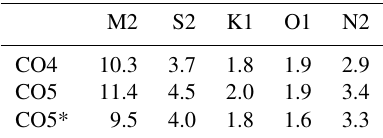
Table 4. Elevation RMSE of amplitude in centimetres as compared to